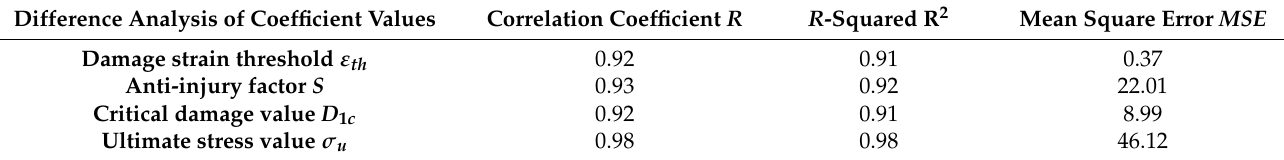
Table 6. The coefficients of the modified Lemaitre damage model for Cr5